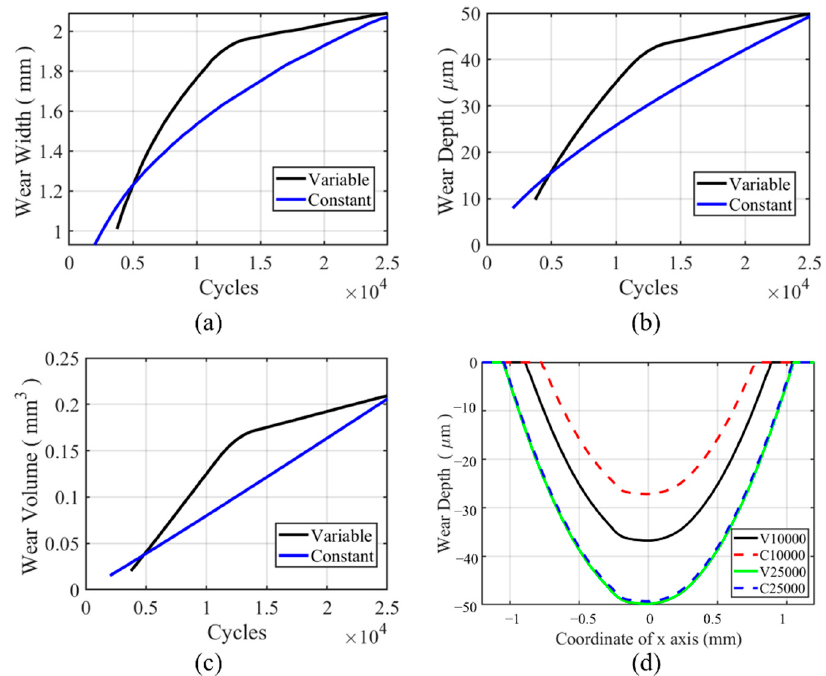
Figure 19. History and profile of wear characteristics for the cylindrical pad in the gross sliding regime for both CWCM and VWCM: ( a – c ) are the history of wear characteristics, and ( d ) is the wear profiles after the 10,000th and 25,000th cycle.